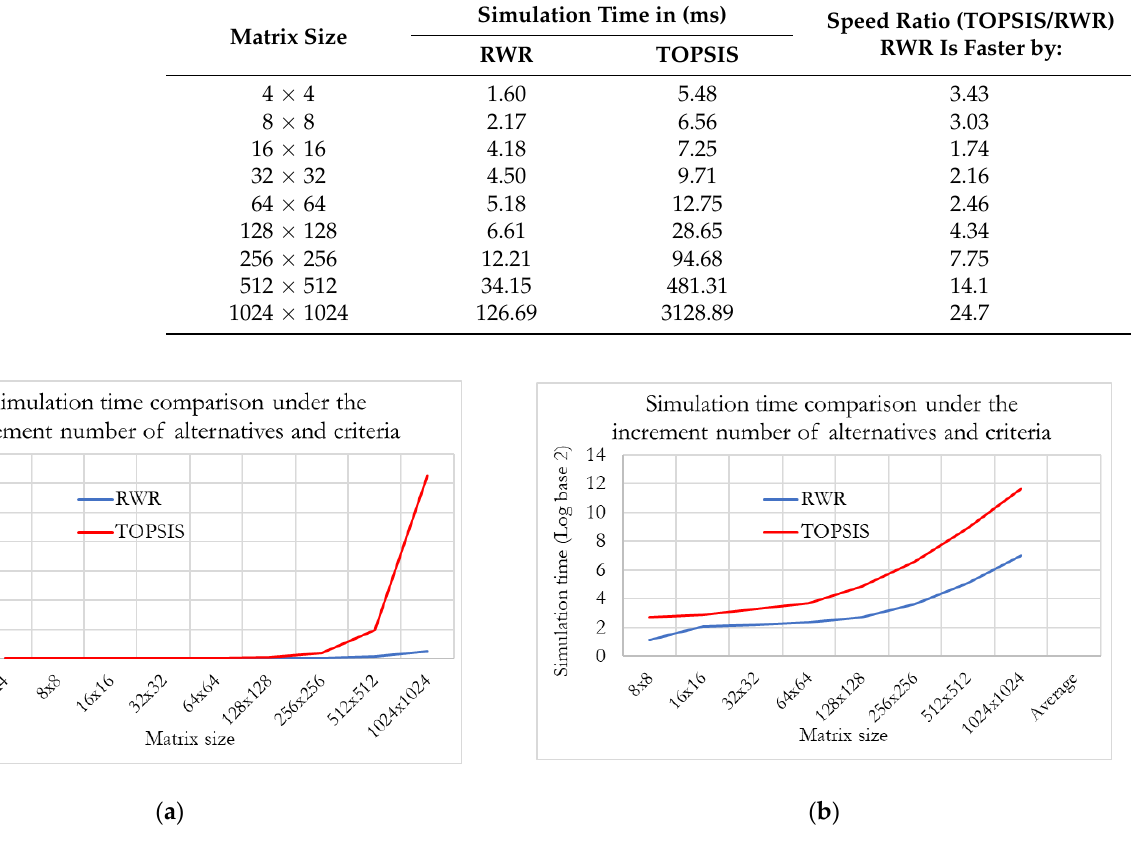
Table 6. Simulation time comparison between RWR and TOPSIS for the same number of alterna- tives and criteria.